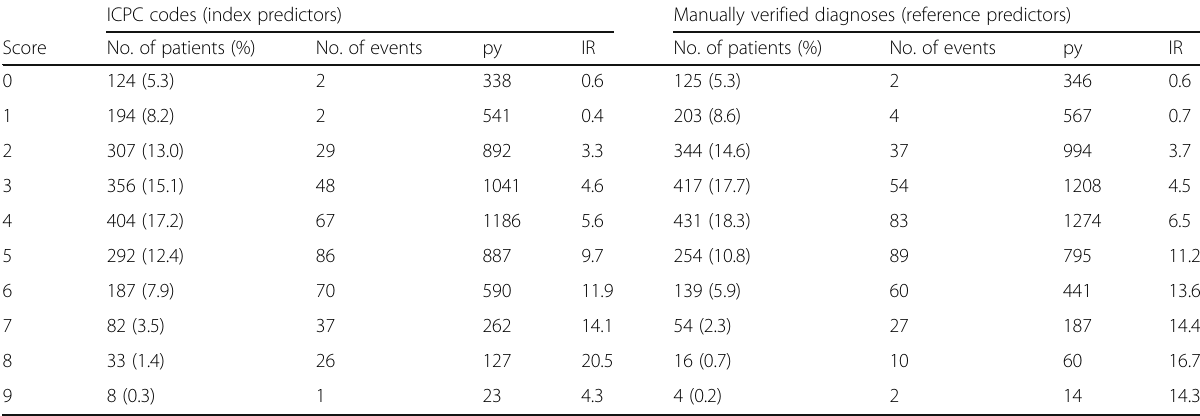
Table 5 Incidence rate of all-cause mortality for each CHA2DS2-VASc score as calculated with ICPC codes (index predictors) or manually verified diagnoses (reference